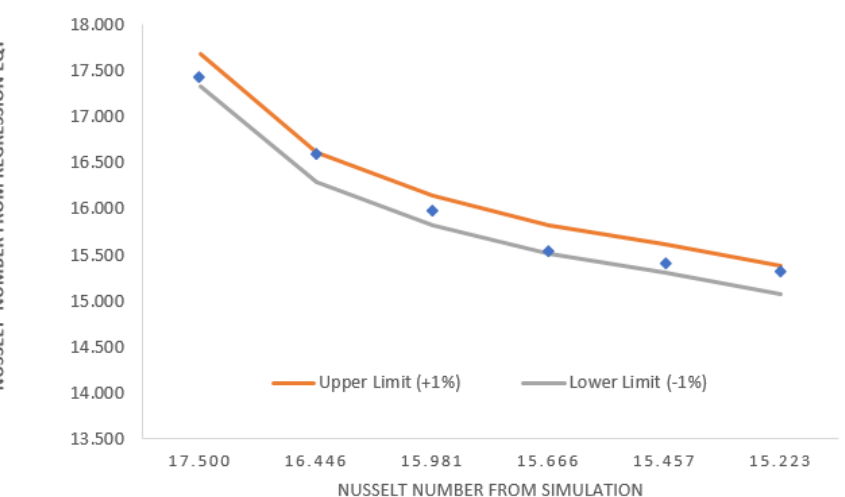
Figure 18. Comparison between Nusselt number from regression EQT vs simulation results.